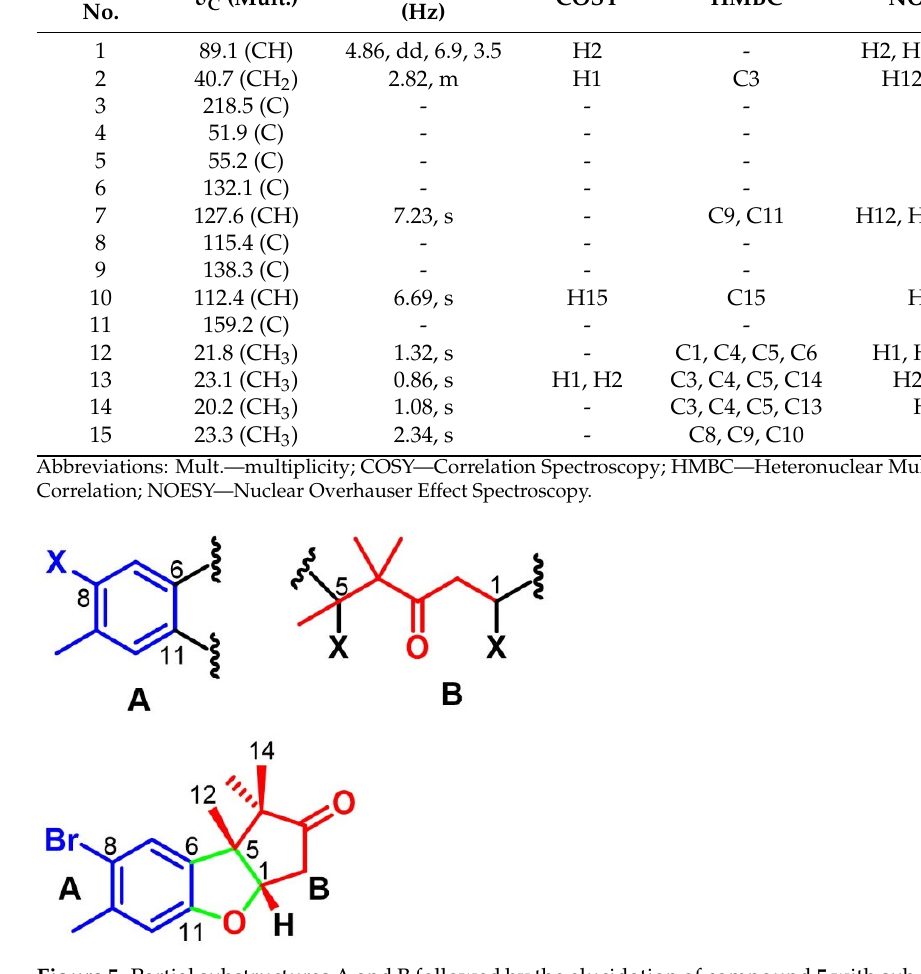
Figure 5. Partial substructures A and B followed by the elucidation of compound 5 with sub ‐ struc ‐ tures A and B attached via a furan ring. A and B attached via a furan